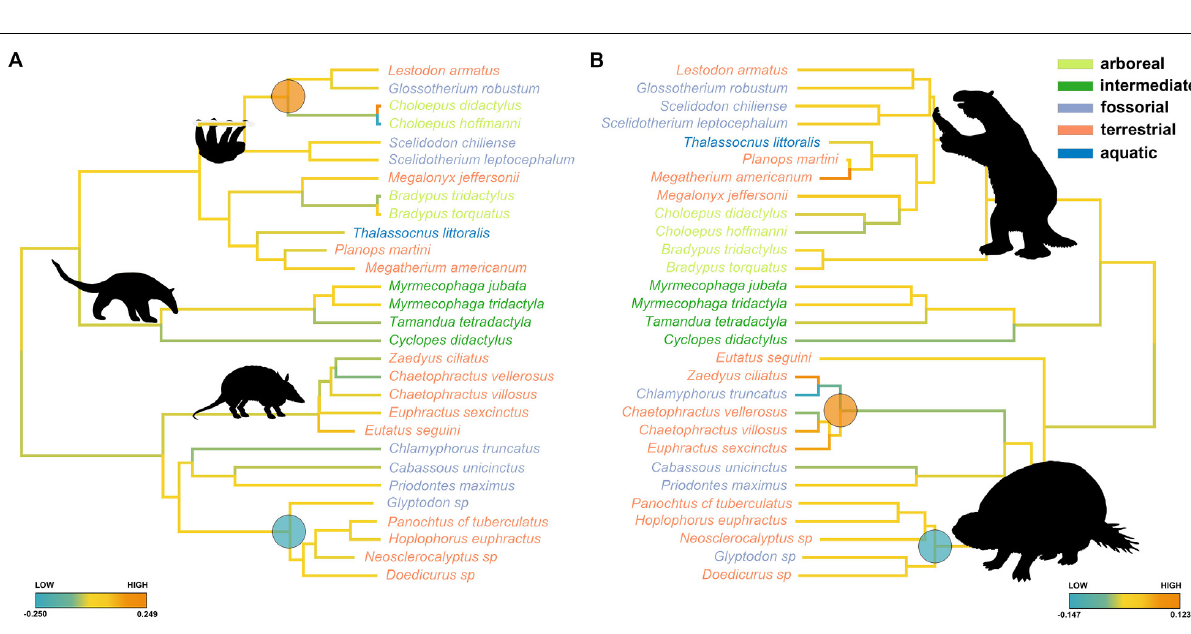
Frontiers in Ecology and Evolution |